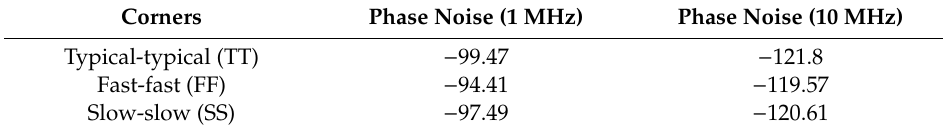
Table 1. Simulation of the proposed voltage controlled oscillator (VCO) in different corners.